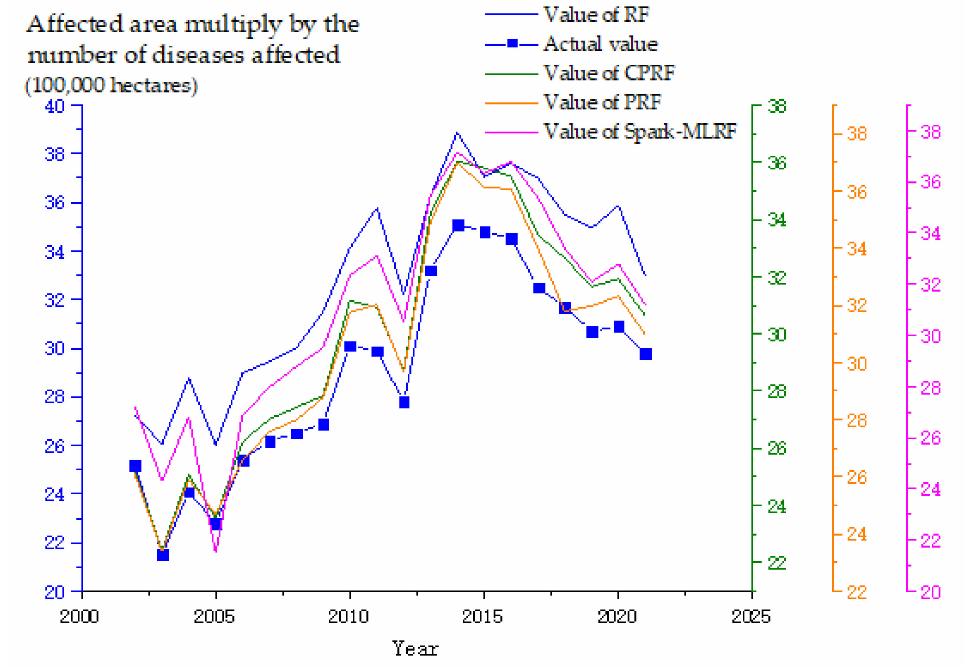
Figure 4. Comparison of four algorithms by using data of an affected area in 20